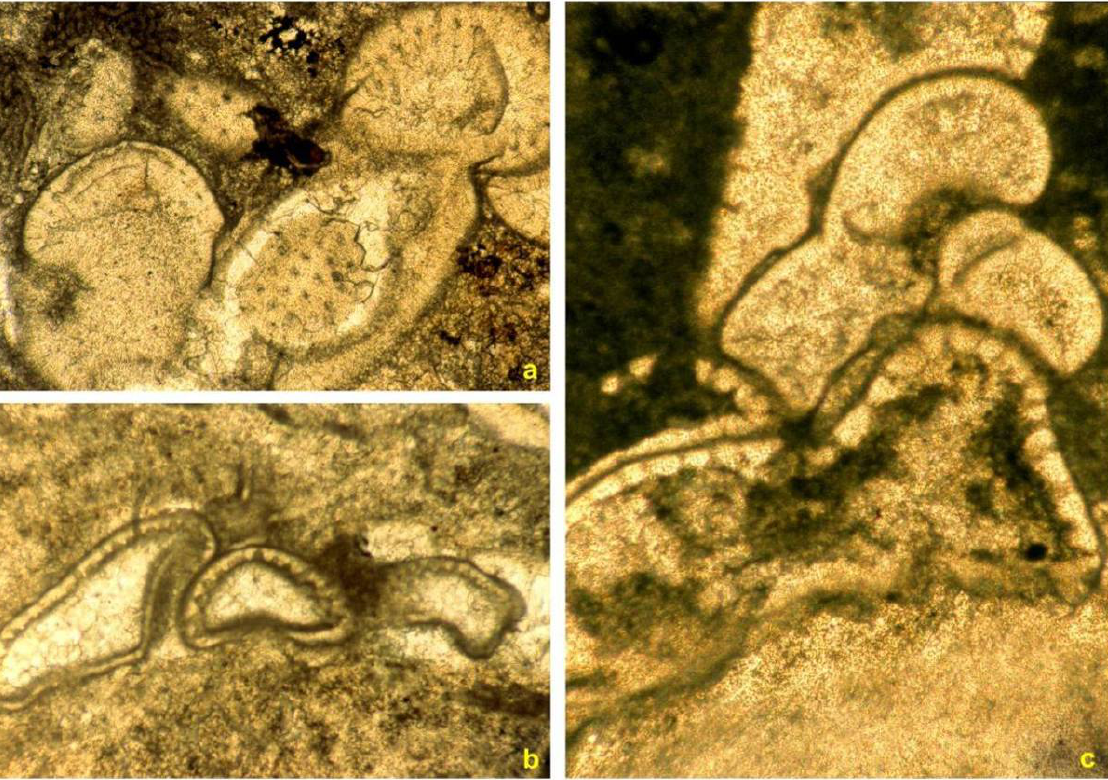
Figure 9. Micrographs of microbial reef fabrics. ( a ) tangential view of ‘Ptestia’ a possible coccoid calcimicrobe, associated with the tubular calcimicrobe Wetheredella (width of view = 2 mm, A1198); ( b ) coccoid ‘Ptestia’ attached to Syringopora corallite base and capped by Wetheredella (width of view = 2 mm, A1198); ( c ) coccoid ‘ Ptestia’ encrusting and covered by the fine tubular calcimicrobe Girvanella and reinforced cavity cement (width of view = 4 mm, A1203); ( d ) encrusting Wetheredella attached to a recumbent Syringopora corallite and completely enveloped in a calcimicrobial spongiostromate casing (width of view = 4 mm, A1198); ( e ) encrusting Wetheredella in fabric of Rothpletzella (width of view = 4 mm, A1196); ( f ) dominant encrusting Girvanella fabric with rare Wetheredella (width of view = 2 mm,